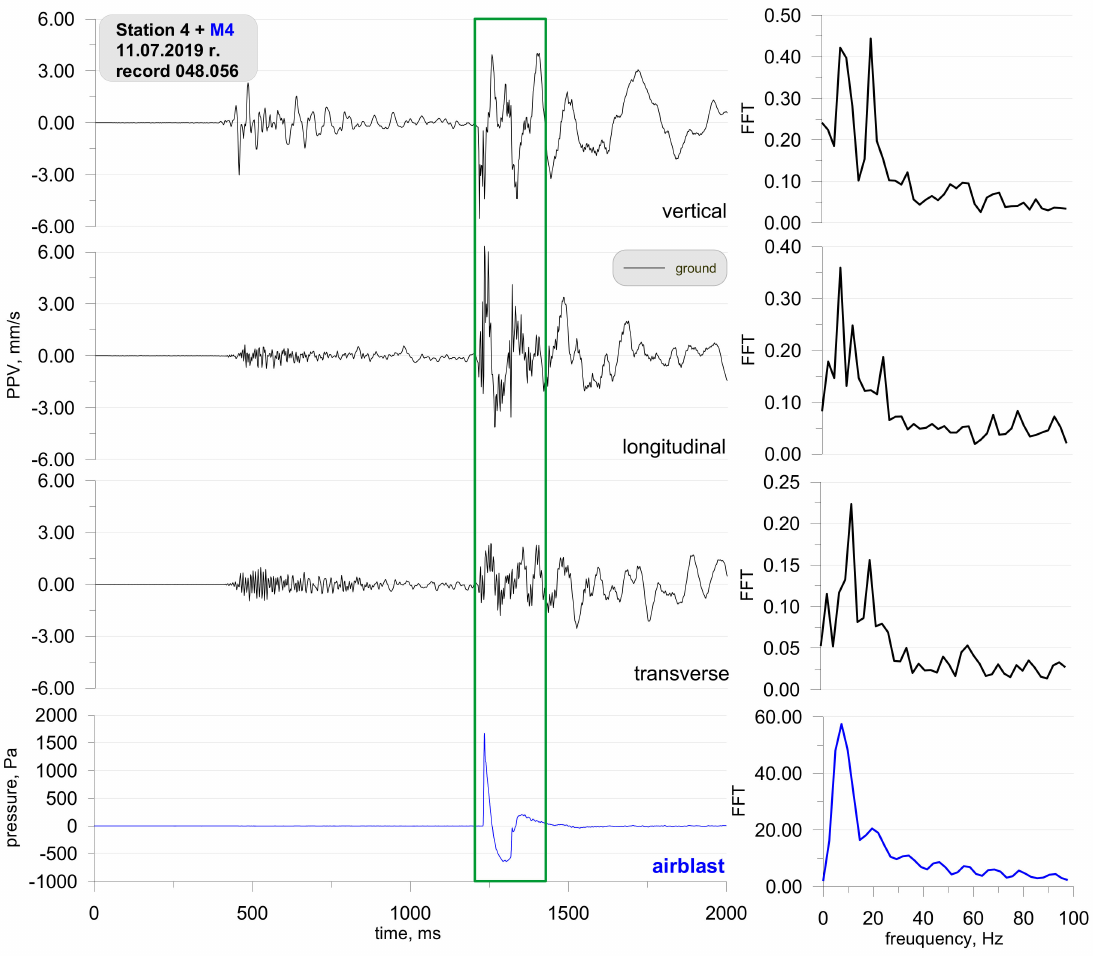
Figure 12. Ground vibration seismogram (three directional components) and recordings of airblast wave pressure together with the analysis of the FFT-Station